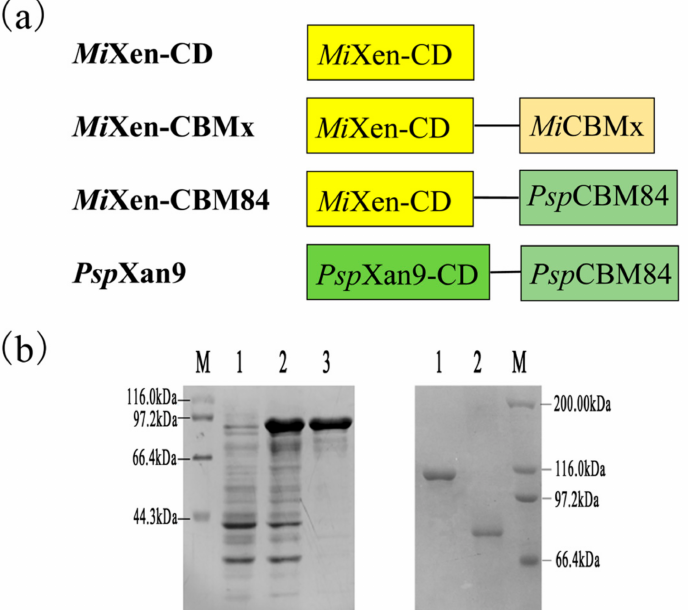
Figure 3. Rational design and SDS-PAGE analysis of recombinant enzymes used in this work. ( a ) Schematic structures of the endotype xanthanases used in this paper. ( b ) SDS-PAGE analysis of endotype xanthanases. Left: Mi Xen-CBM84. Lanes M: protein molecular weight markers, Lanes 1: carrier protein, Lanes 2: soluble protein, Lanes 3: purified protein. Right: SDS-PAGE analysis of Mi Xen-CBMx and Mi Xen-CD. Lanes M: protein molecular weight markers. Lanes 1: purified Mi Xen-CBMx. Lanes 2: purified Mi